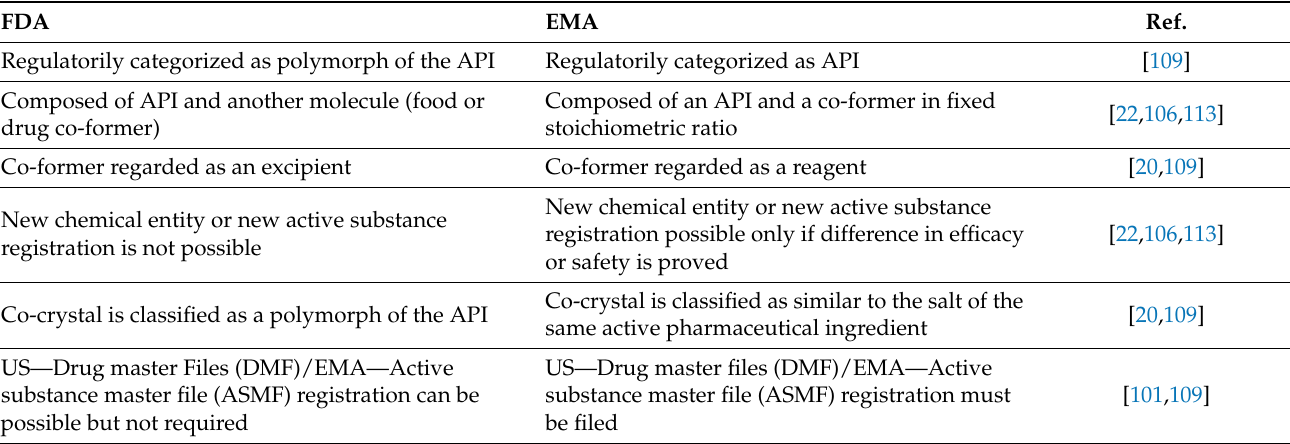
Table 5. Summary of classifications between USFDA and EMA